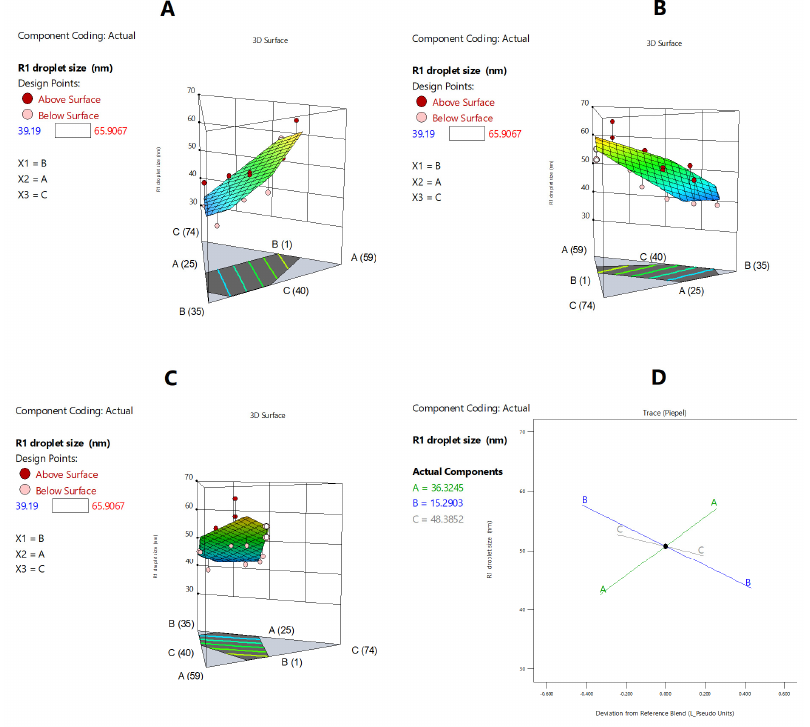
Figure 3. Graphical representation of the effects of the formulation components on droplet size: ( A – C ) The 3D surface representations of the effects of the proportions of BSO, TCP, and HCO-30, respectively, on droplet size. ( D ) Trace-type representation of the effects of the formulation components on droplet size. A: BSO % w / w ; B: TCP % w / w ; C: HCO-30 % w / w